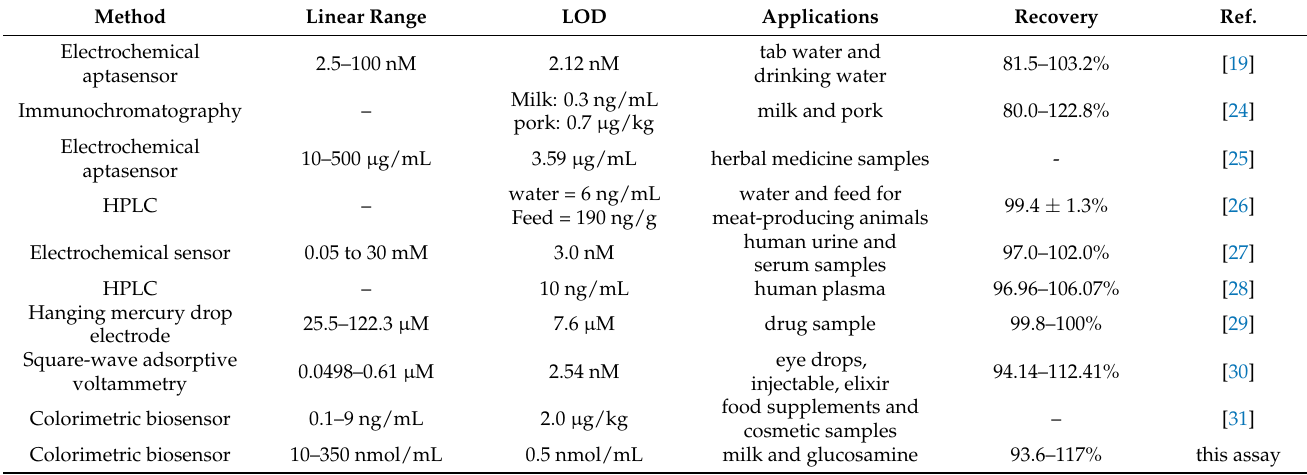
Table 2. Existing Dexamethasone Determination Method Comparison